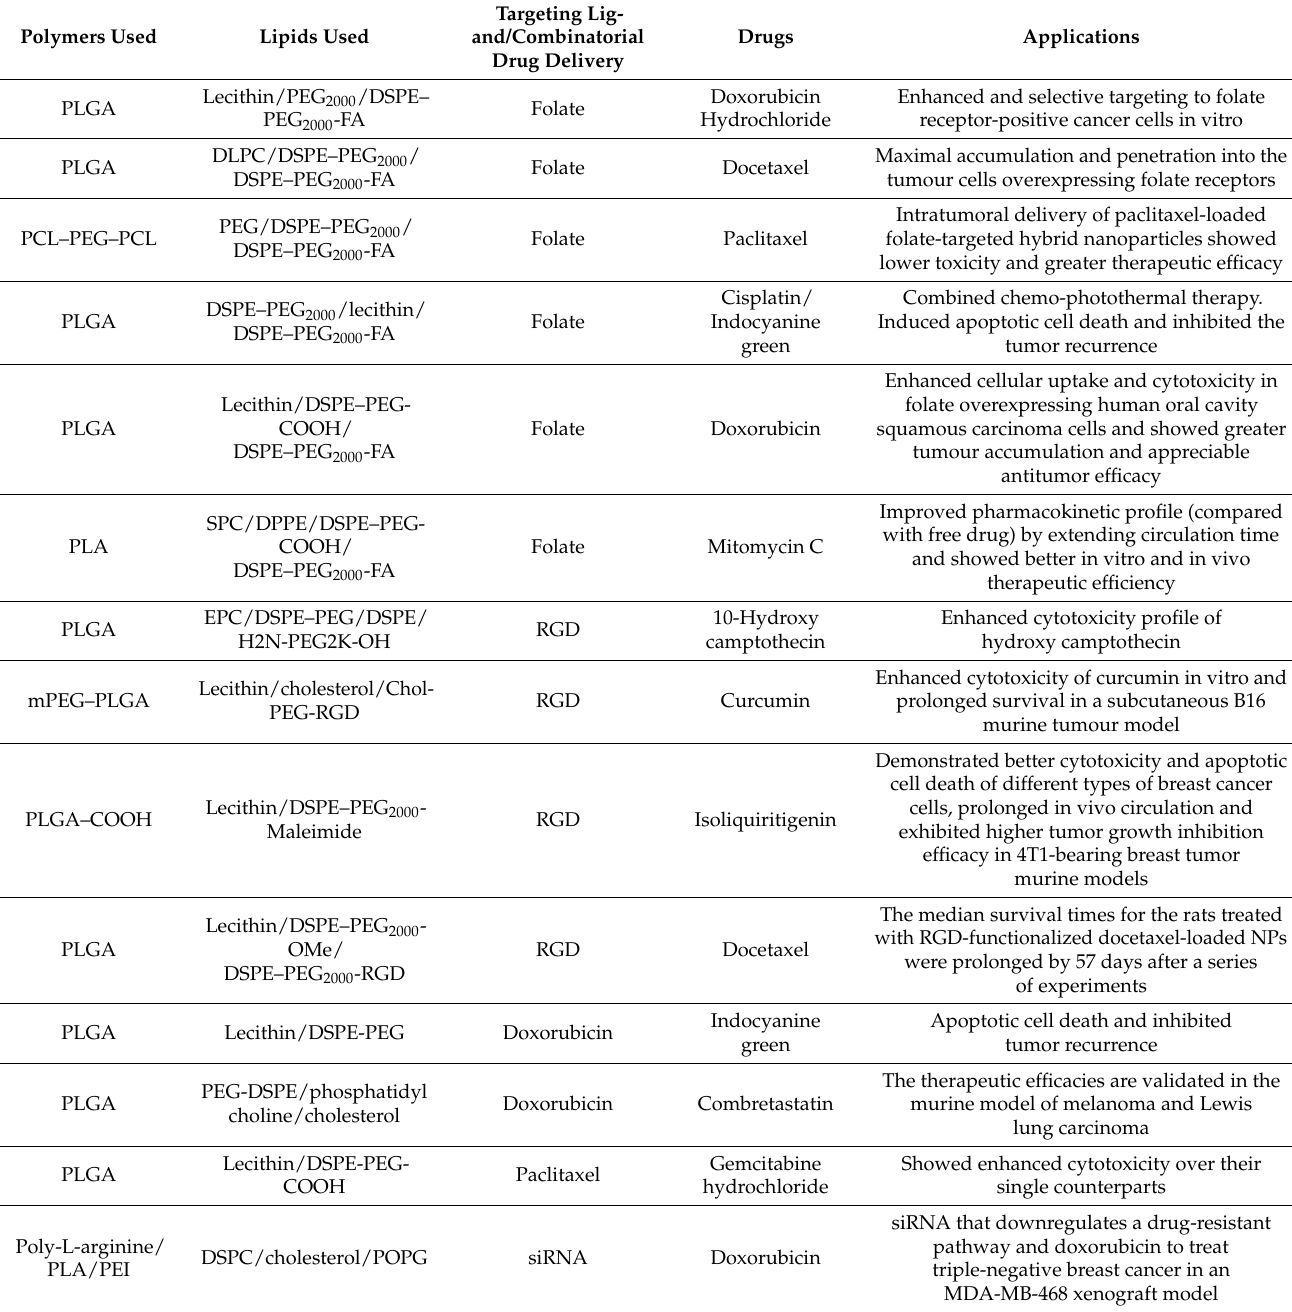
Table 4. Therapeutic applications of PLNs